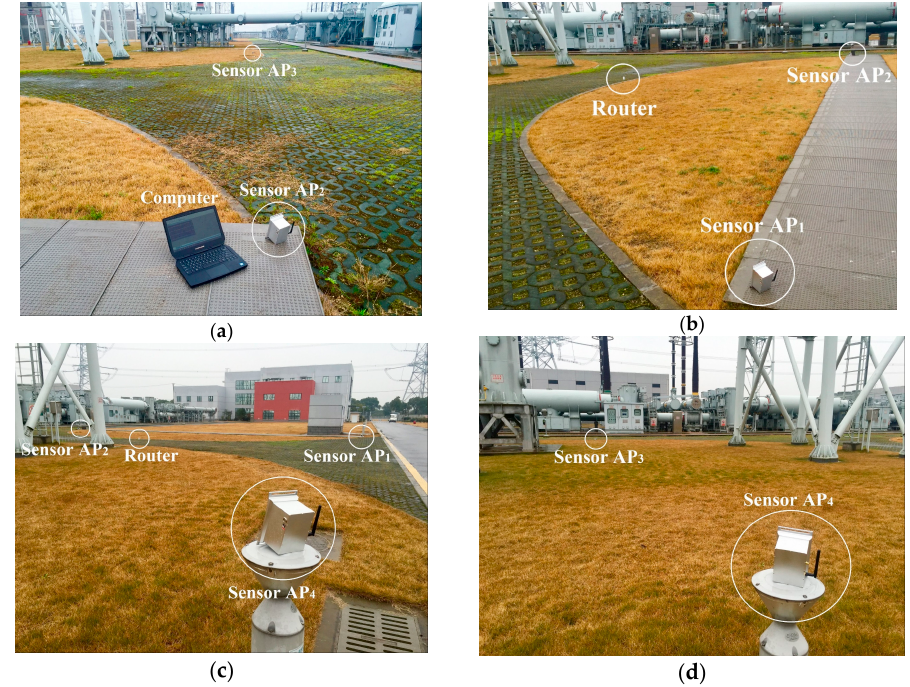
Figure 12. The picture of test site. ( a ) Picture 1; ( b ) Picture 2; ( c ) Picture 3; ( d ) Picture 4. Table 1. Parameters settings for affinity propagation clustering algorithm.